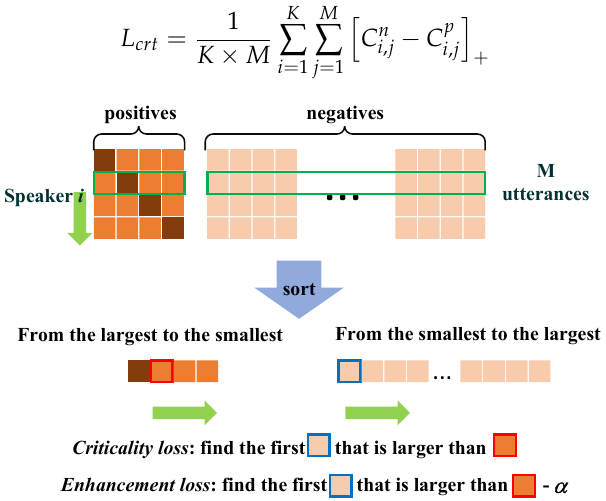
Figure 6. Diagram of the critical sample selection of Criticality-Enhancement Loss (CEL). The values of the dark brown blocks in positives are one and could be skipped. Given the current positive (framed by the red box), the negatives are traversed (represented by the blue box) until the values in the boxes meet the